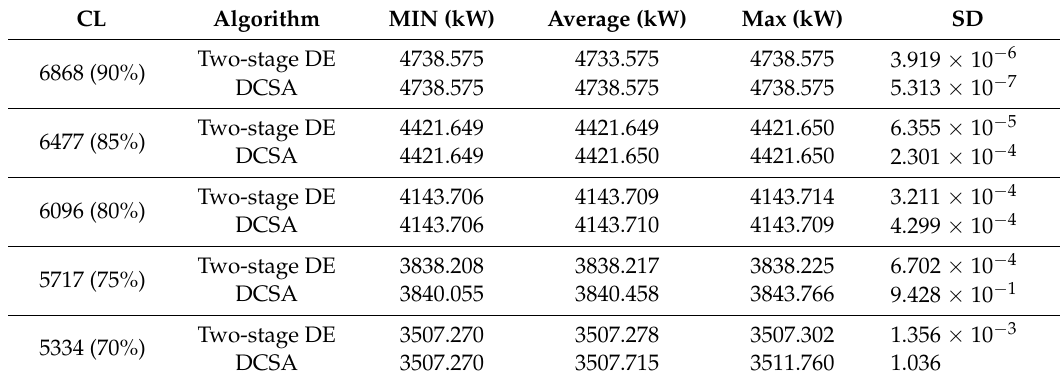
Table 2. Case study 1: comparison with DCSA.